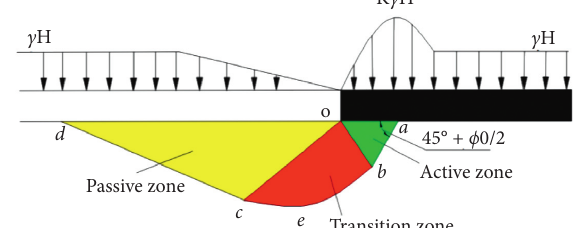
Figure 2: Diagram for calculating maximum failure depth of